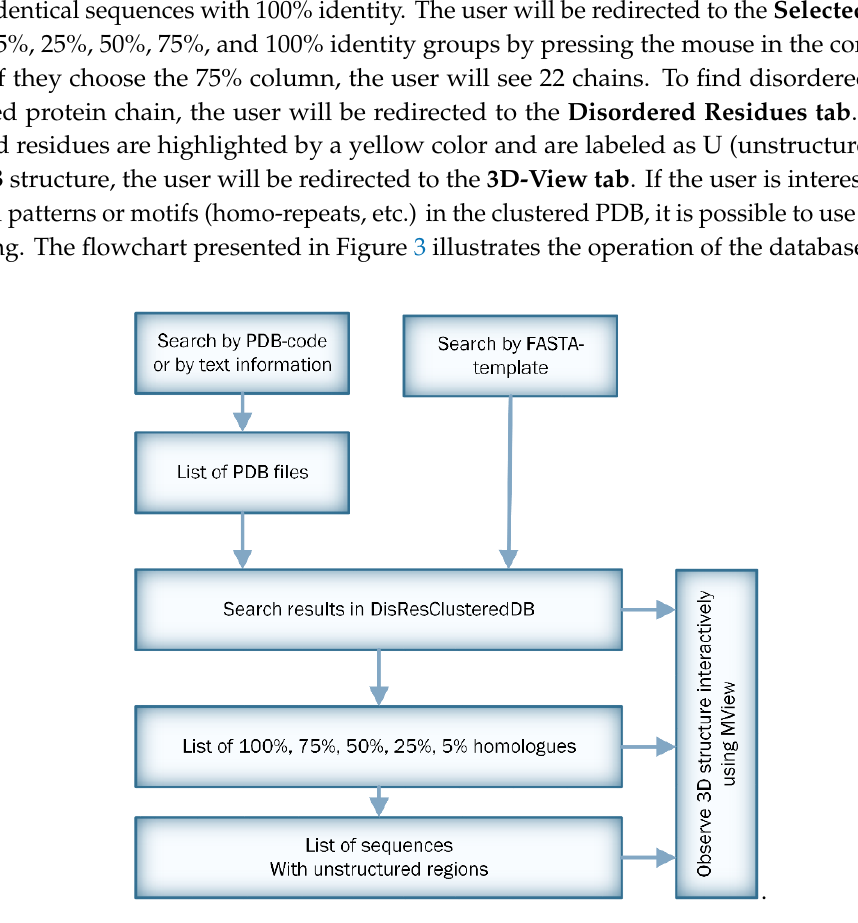
Figure 3. Scheme for server processing.